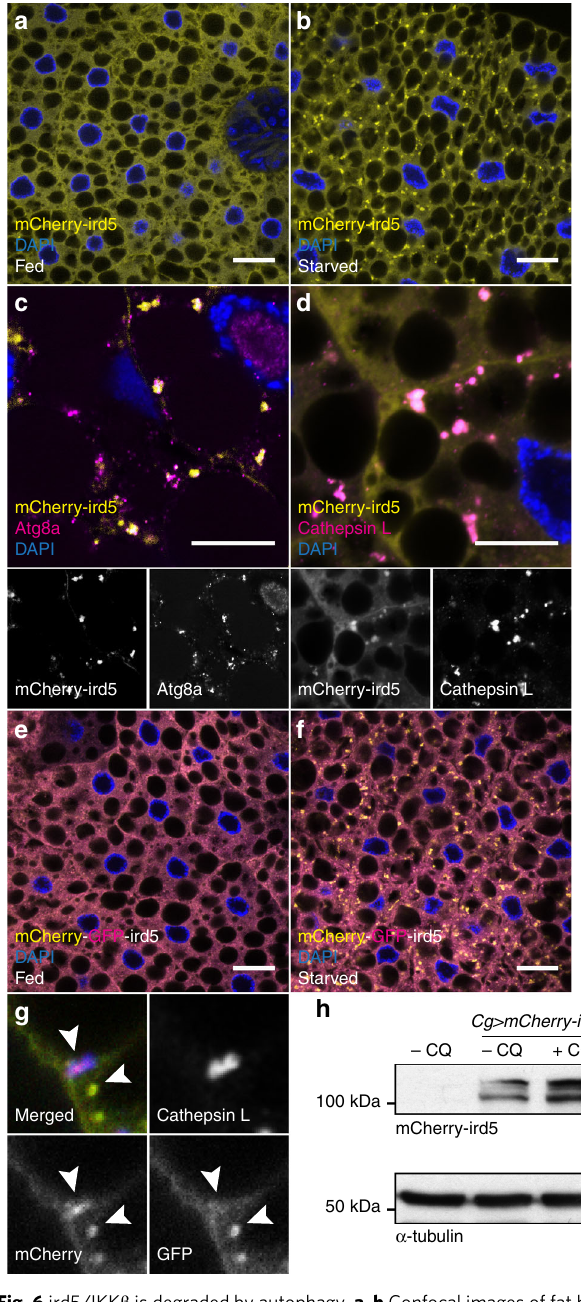
Fig. 6 ird5/IKK β is degraded by autophagy. a , b Confocal images of fat body cells from fed a and starved b larvae expressing mCherry-ird5 (yellow). c , d Co-localization between mCherry-ird5 (yellow) and Atg8a (magenta) c or Cathepsin-L (magenta) d . Insets show the separate channels for mCherry- ird5 (lower left), Atg8a (lower right), and Cathepsin-L (lower right). e , f Confocal images of fat body cells from fed e and starved f larvae expressing a tandem-tagged mCherry-GFP-ird5 (yellow and magenta). g High magni fi cation of fat body cells from starved larvae expressing mCherry- GFP-ird5 (green and red, lower panels), stained for Cathepsin-L (upper right panel). Arrowheads show ird5 in autophagosomes (both red and green signals co-localize) and in autolysosomes (only the red signal is detectable due to GFP quenching). Scale bars are 20 µ m a , b , e , f and 10 µ m c , d . h Western blot analysis of lysates from larvae fed for 25 h with food supplemented with 2.5 mg/mL Chloroquine (+CQ) or vehicle ( −